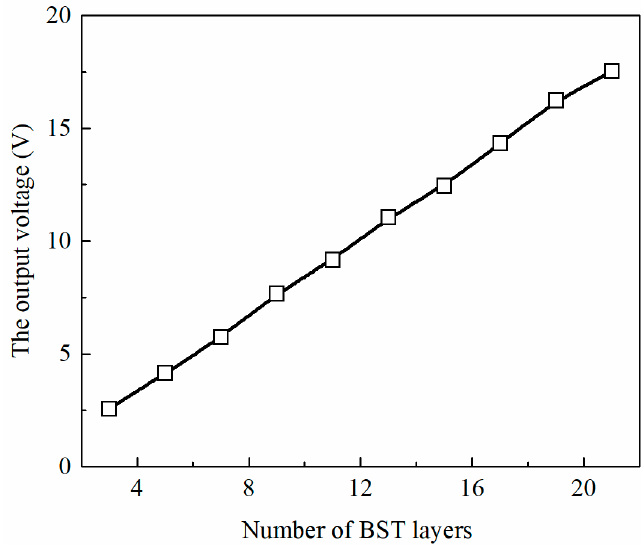
Figure 8. Output voltage of micro scale flexoelectric laminated beam energy collection device with fixed thickness.